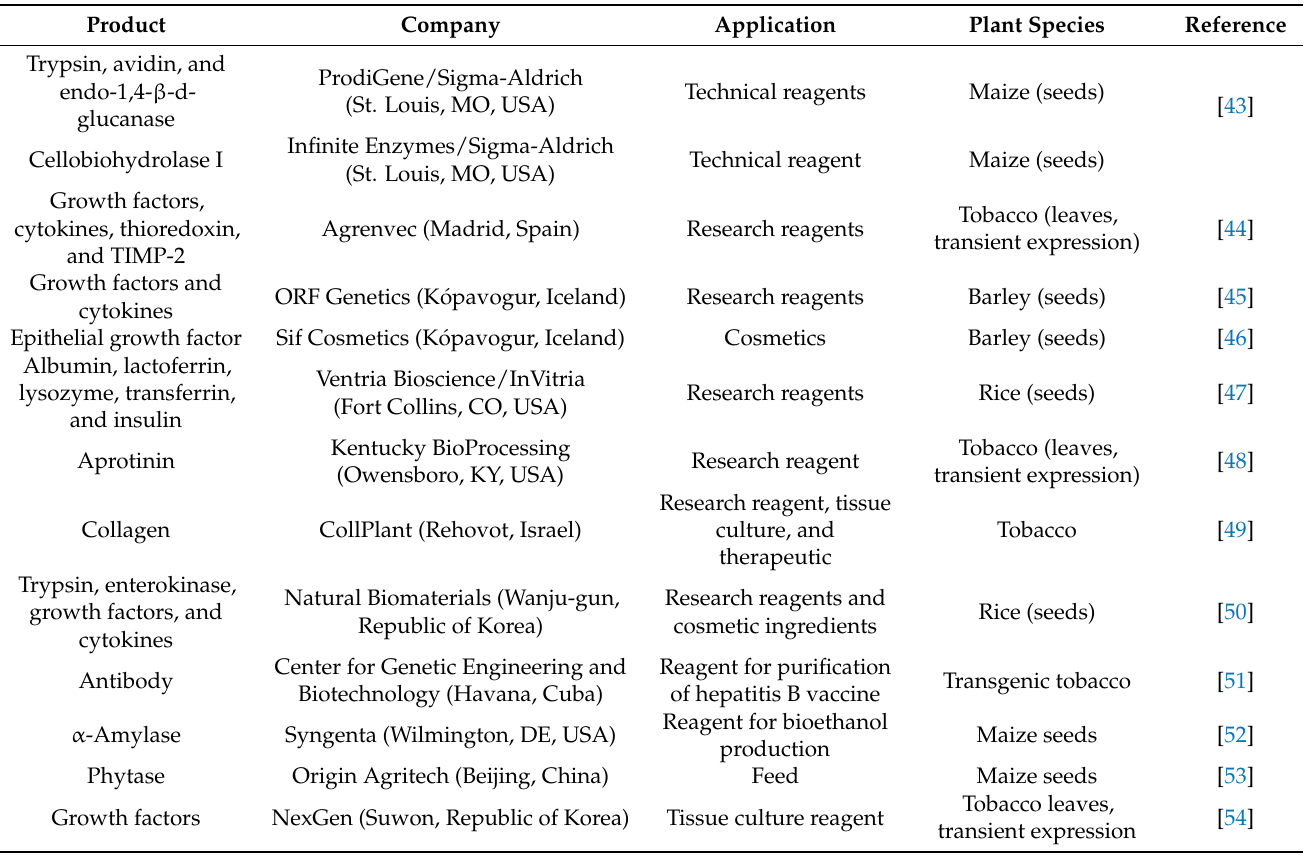
Table 2. Commercial nonpharmaceutical proteins produced in